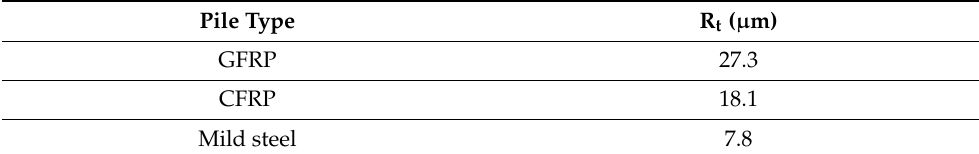
Figure 8. Effect of surface roughness under an axial load ( a ) and effect of loading rate on CFRP piles under an axial load ( b ). Table 4. Surface roughness (R t ) of different types of FRP.